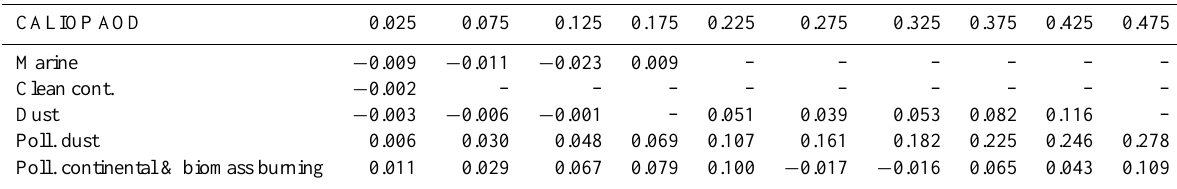
Table 6. Median AOD layer bias (CALIOP – HSRL) for each CALIOP aerosol type as a function CALIOP AOD (Nighttime, bin width of 0.05). CALIOP